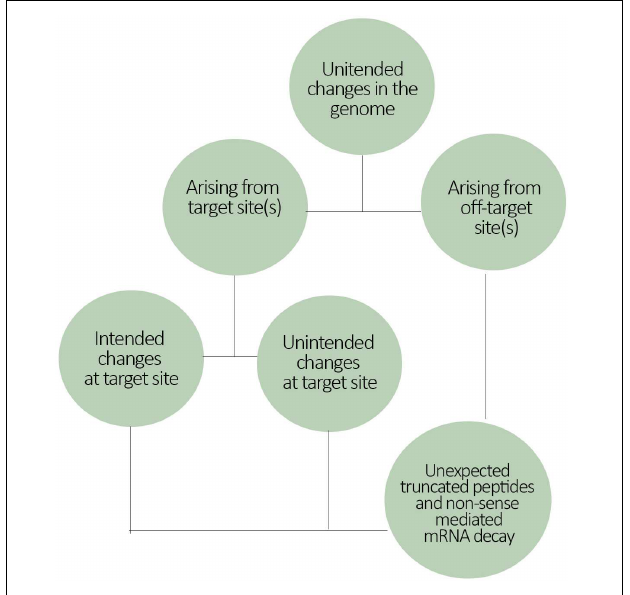
FIGURE 3 | Flowchart illustrating the potential source of gene-editing mediated genome changes. Genome changes can vary in location (target and/or off-target sites), in quantity (how many sites were changed) and also in quality (deletion, insertion, substitution of nucleotides in a sequence). Therefore, genome changes at target site can have both intended and unintended effects depending on the quality/type of the